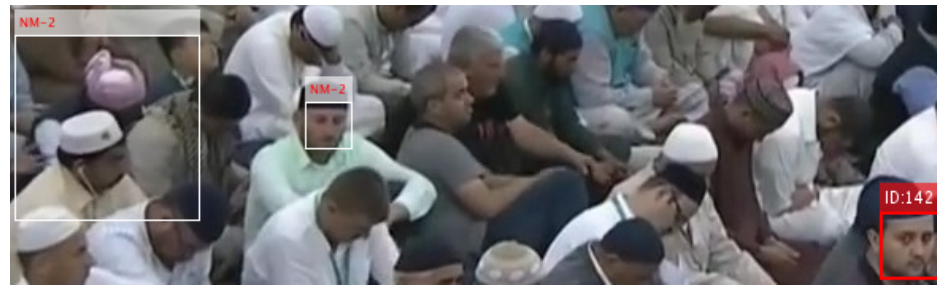
Figure 8. Extracted face regions: ( a ) cropped; ( b ) Enhanced & resized.